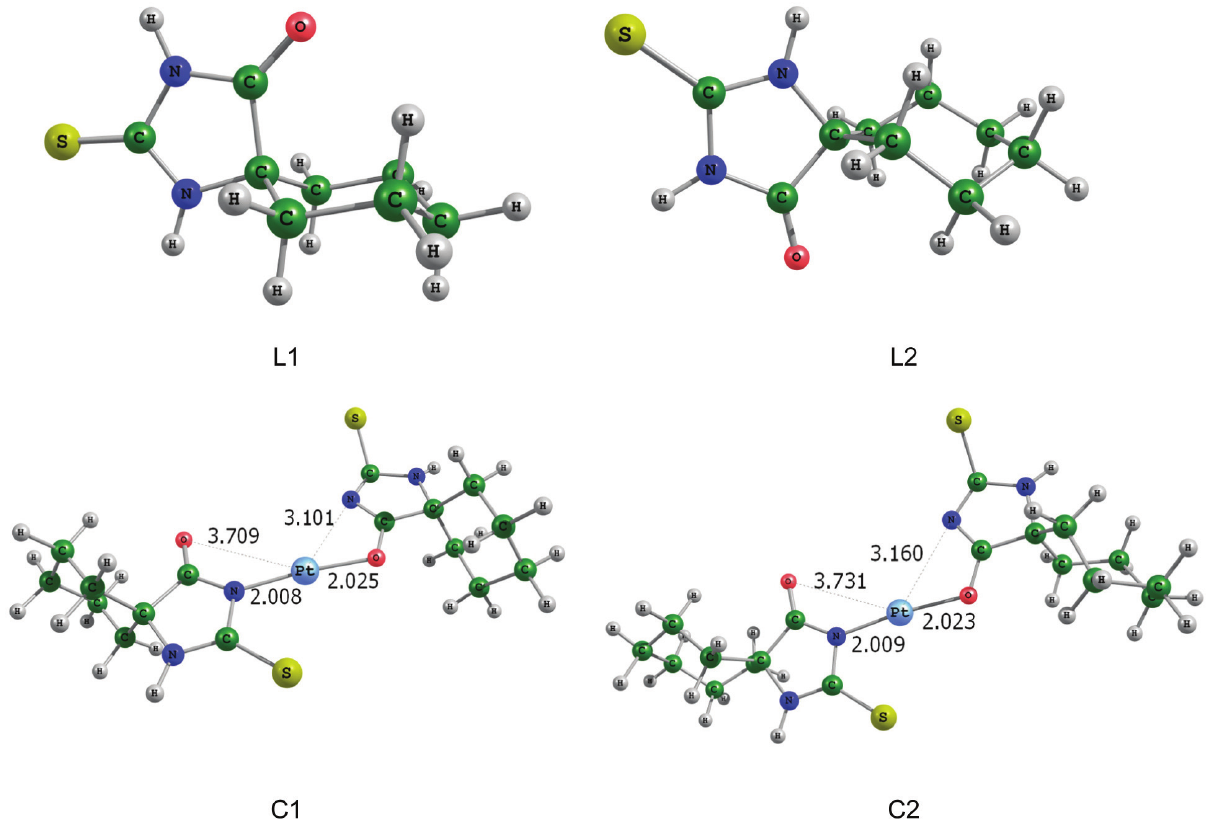
Figure 1. Ground-state equilibrium geometries of the ligand and complexes of cyclohexanespiro-5-(2-thiohydantoin) (L1) and cycloheptanespiro- 5-(2-thiohydantoin) (L2) as obtained at the BLYP/CEP-31G